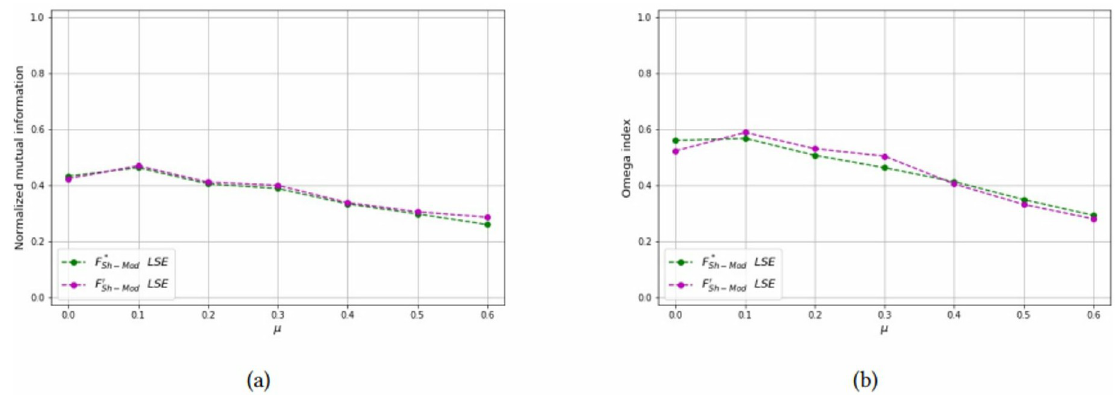
Fig 21. Test results on overlapping communities, parameters N = 500, n c = 25, p = 2, μ o = 0.6, N o = 50. (a) Average NMI for each solution method, (b) Average Omega for each solution method.